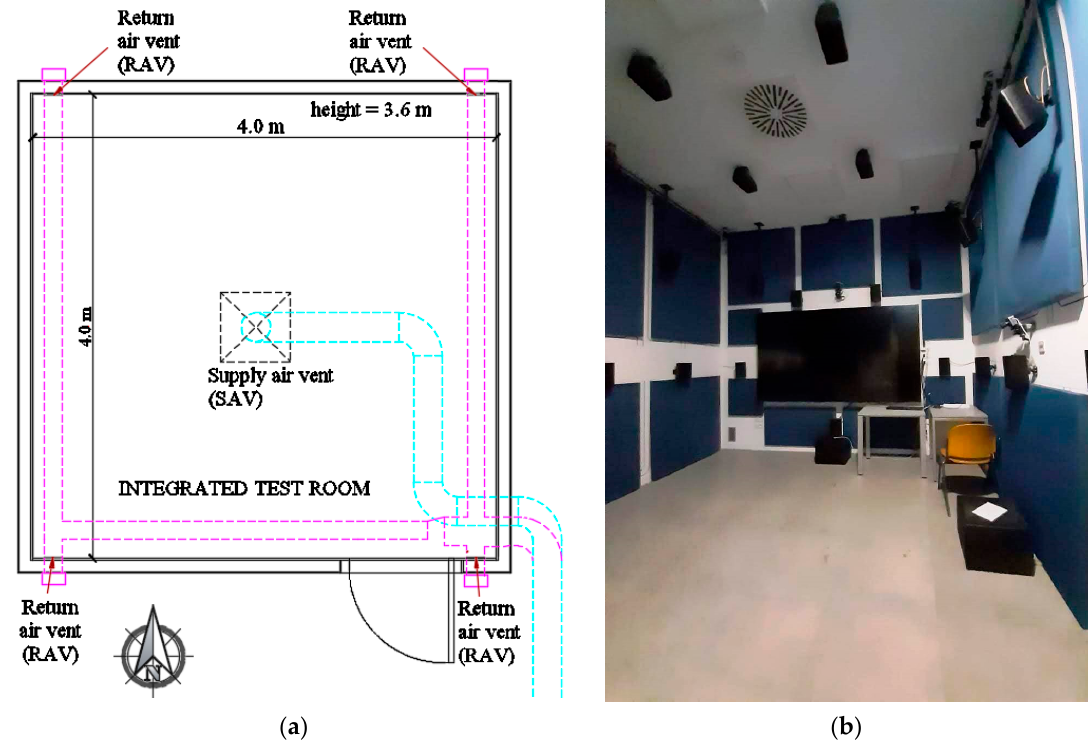
Figure 1. ( a ) Floor plan, and ( b ) internal view of the Integrated Test Room.